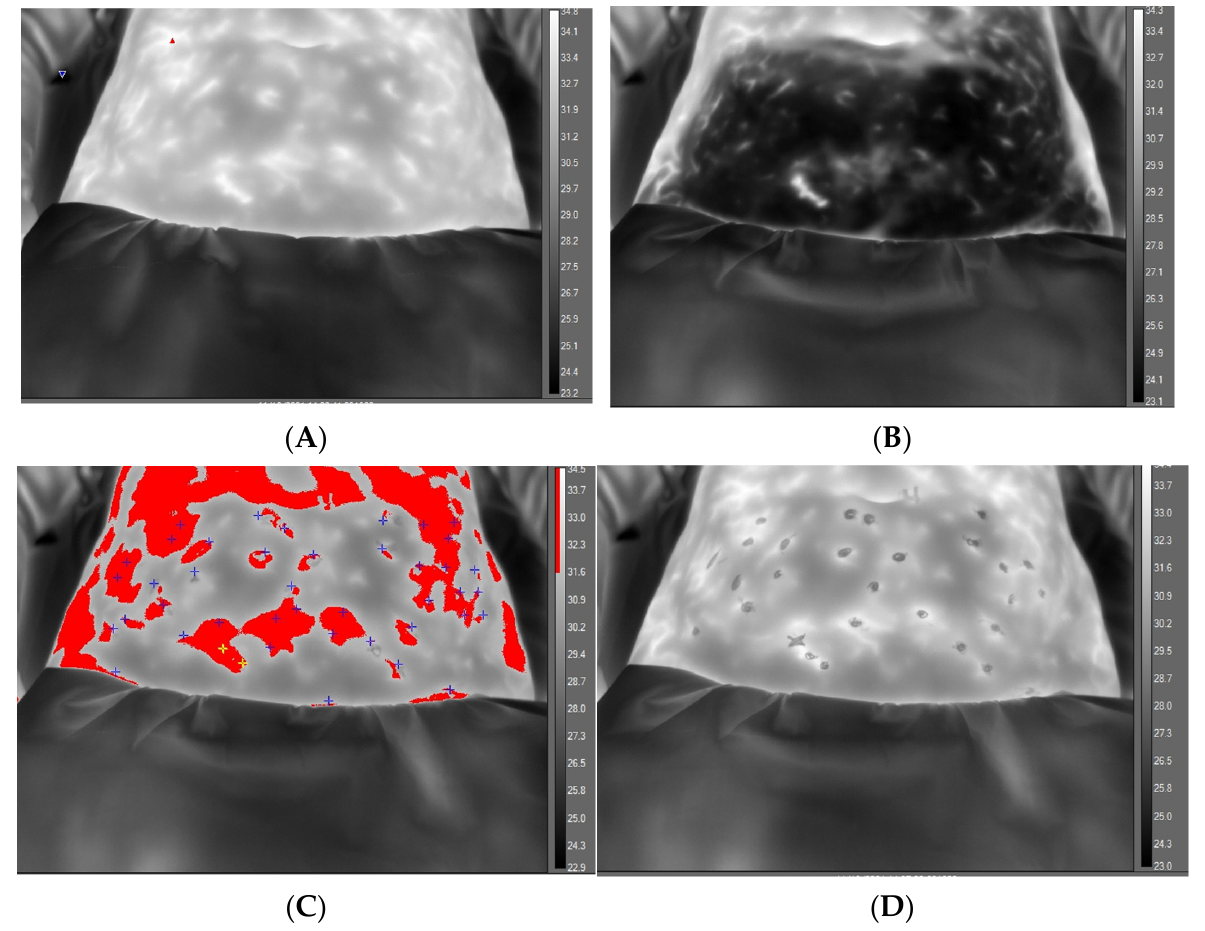
Figure 3. Greyscale thermal image of abdomen at baseline, before application of cold challenge and with temperature scale, ( A ). Abdomen appearance after 2 min of cooling showing effect of cooling in reducing regional temperature, ( B ). Abdomen appearance at 10 min, revealing ‘hot spots’ distinguished by isotherm feature (red) and with post-processing markers (+) indicating location of perforators, ( C ). Final video-thermography frame at end of recovery phase with isotherm removed and ‘spots’ indicating location of marked hotspot before perforasome evolution, ( D ).